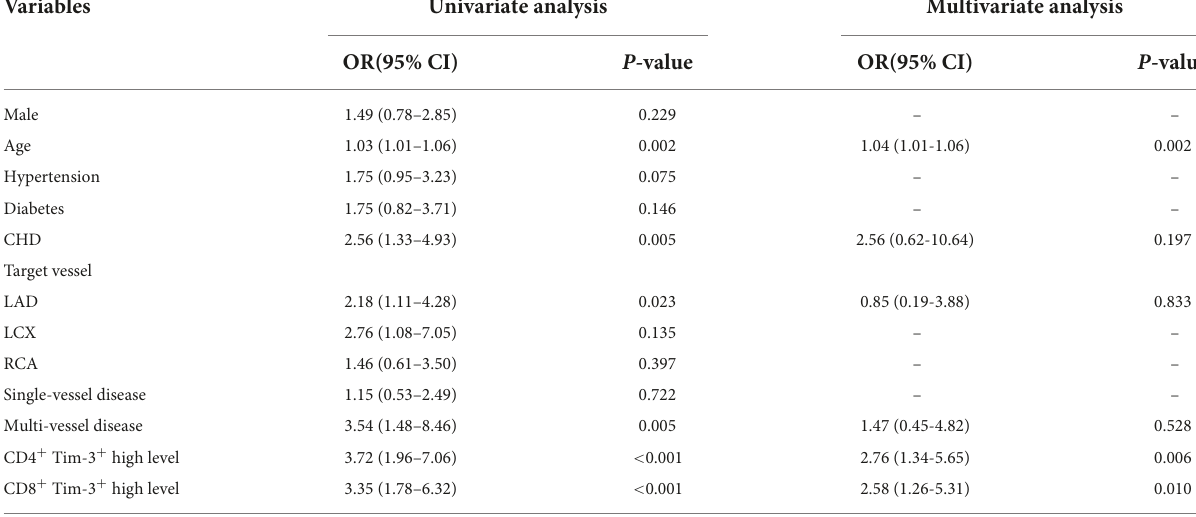
TABLE 3 Logistic regression analysis of the correlation between specific markers, risk factors and ADHF events.